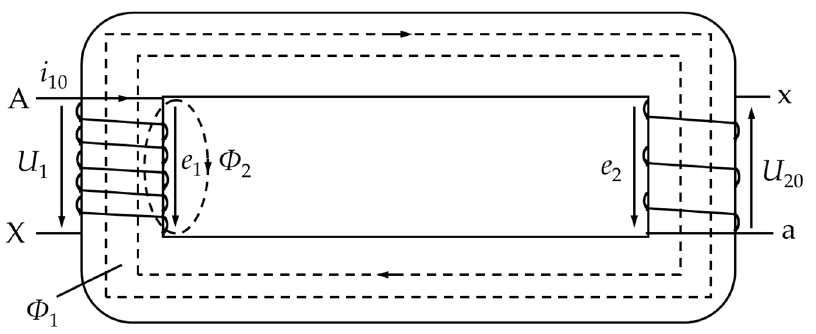
Figure 1. Single-phase HFT magnetic fl ux diagram.